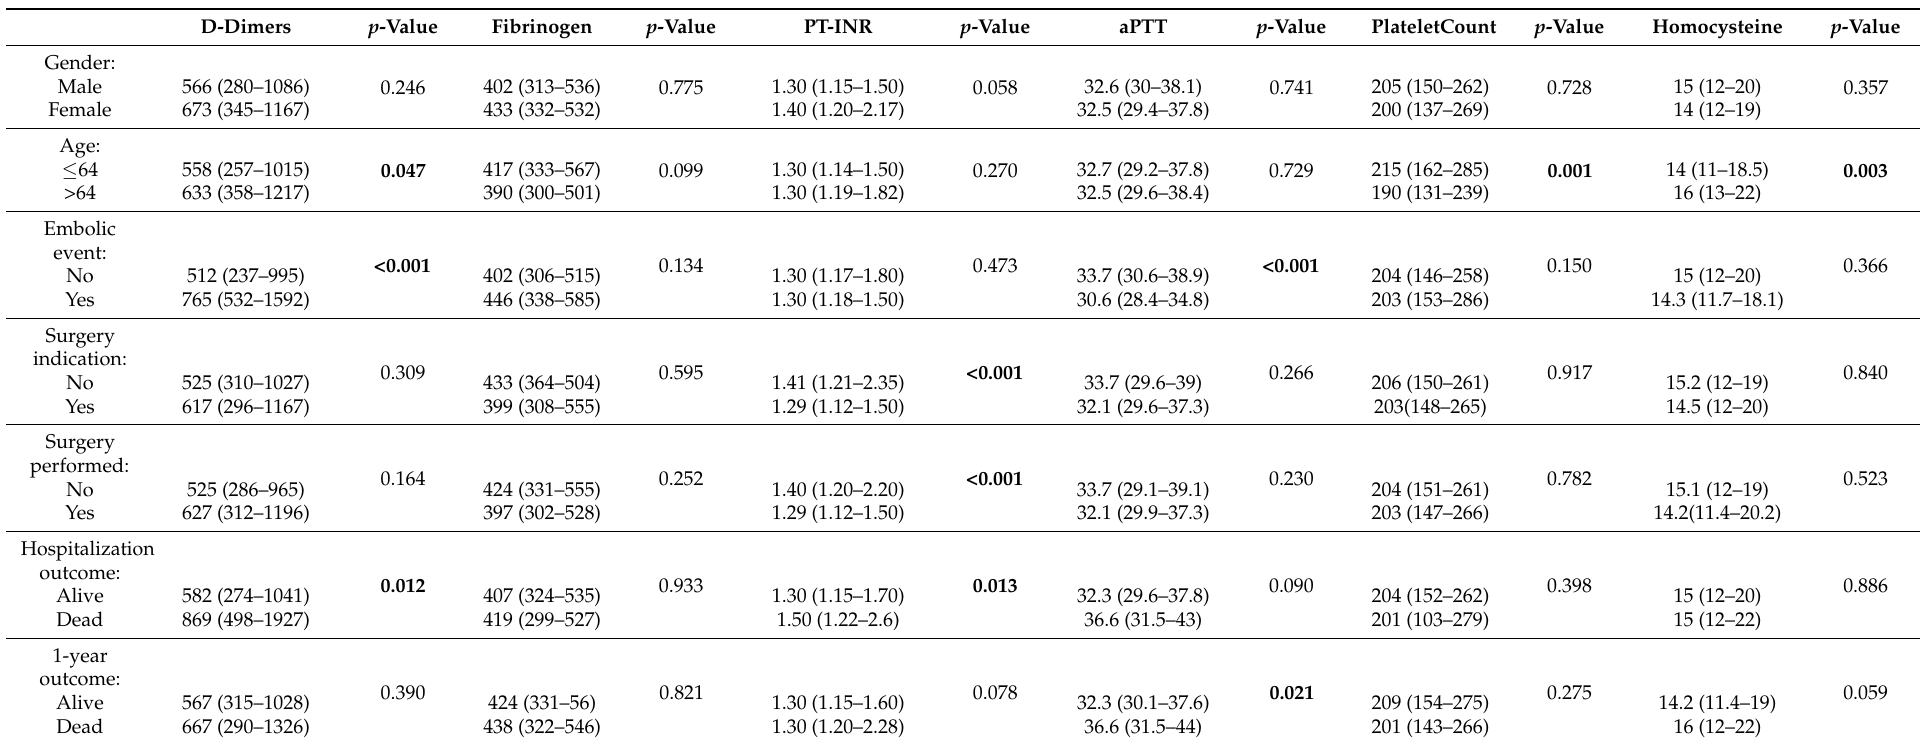
Table 2. Coagulation parameters in relation to major clinical features and mortality of IE